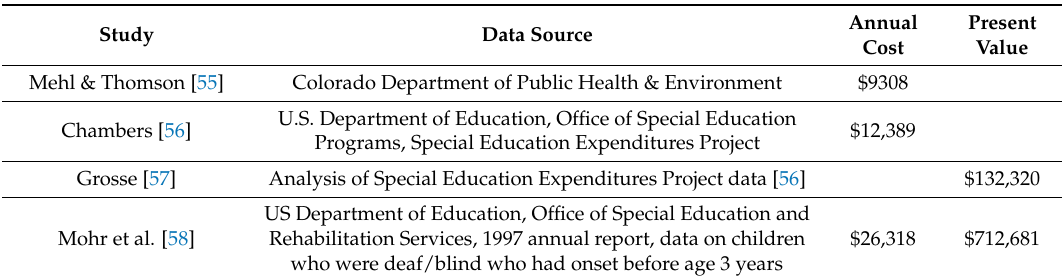
Table 2. Estimated annual and/or discounted present value of incremental costs of special education associated with permanent congenital hearing loss in US children, 2016 US